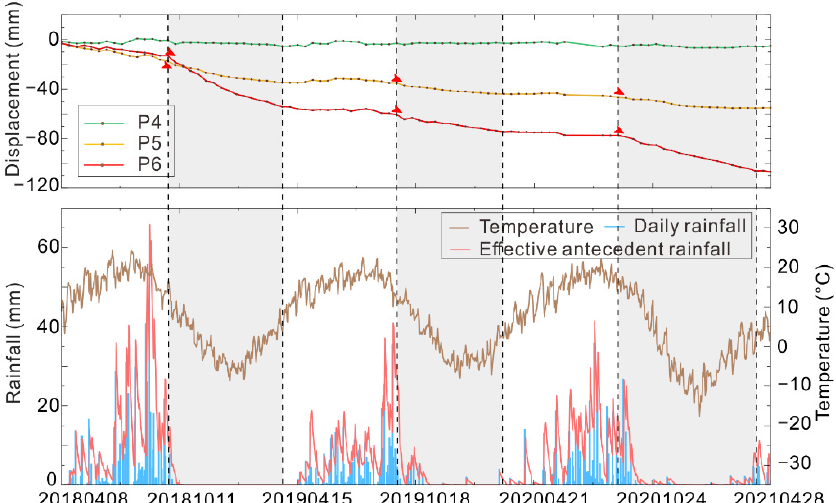
Figure 11. The time-series LOS displacement, effective antecedent rainfall and temperature after the landslide occurred. The locations of P4, P5 and P6 are shown in Figure 8. The red triangle represents the beginning of the accelerated change. The gray bar represents the time span of the accelerated displacement.